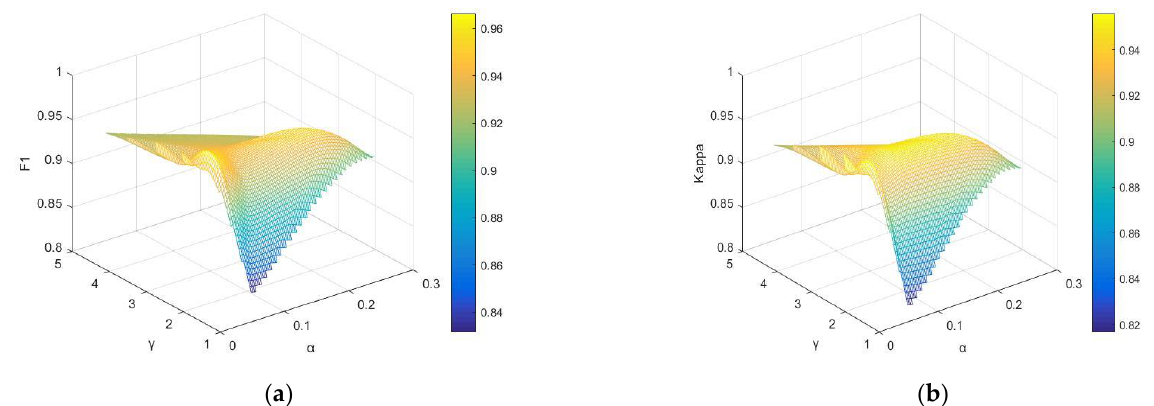
Figure 5. Triangular surface maps of F1 and Kappa on the verification sets: ( a ) F1-score of verification set 1; and ( b ) Kappa coefficient of verification set 1.